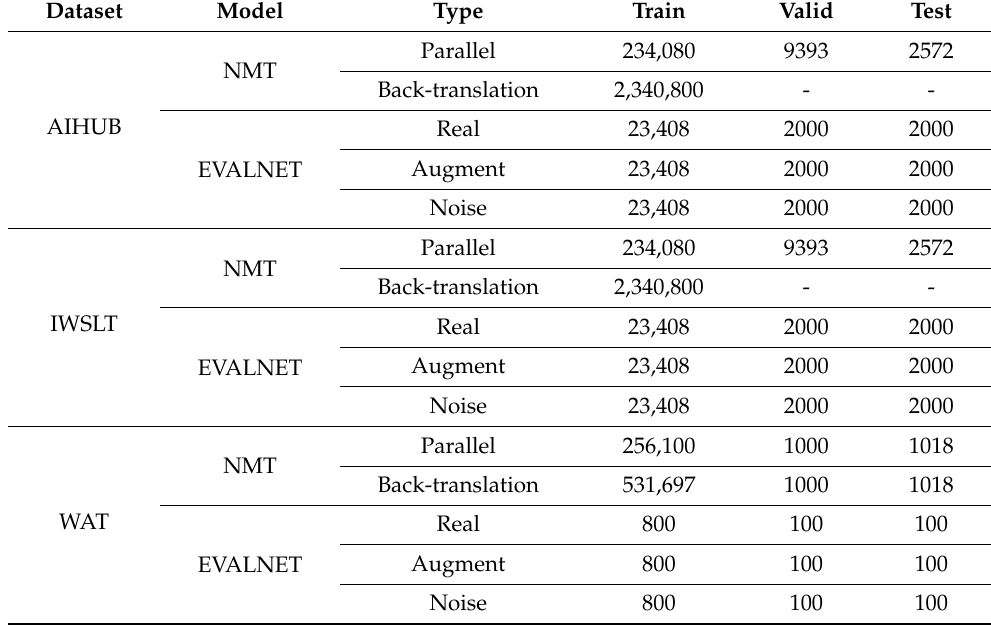
Table 1. Statistics of the training data of the NMT systems and